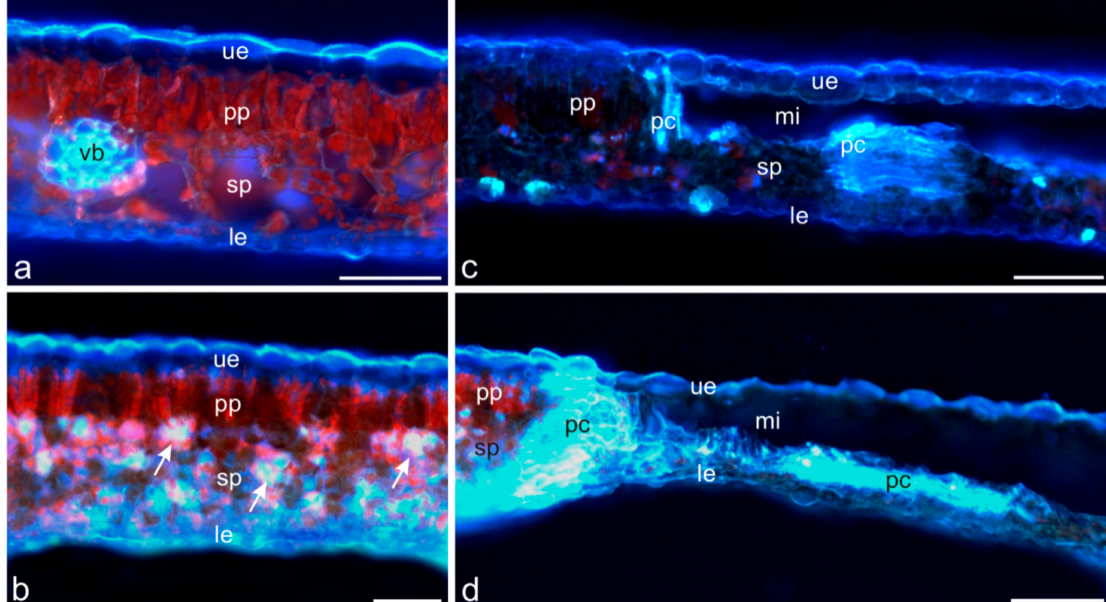
Figure 6. Light blue autofluorescence of phenolic compounds in Camararia ohridella -uninfested ( a ) and infested ( b – d ) Aesculus hippocastanum leaf tissues. ( a ) Autofluorescence of phenolic compounds visible in the adaxial epidermis and in the vascular bundle cell walls. ( b , c ) Infested leaves collected in July: autofluorescence of phenolic compounds visible in the adaxial and abaxial epidermis and in the spongy parenchyma (arrows) ( b ) and in tissues adjacent to the pest foraging site ( c ). ( d ) Infested leaves collected in September: autofluorescence of phenolic compounds visible on the bottom of the mines and in the palisade and spongy parenchyma cells adjacent to the mine.